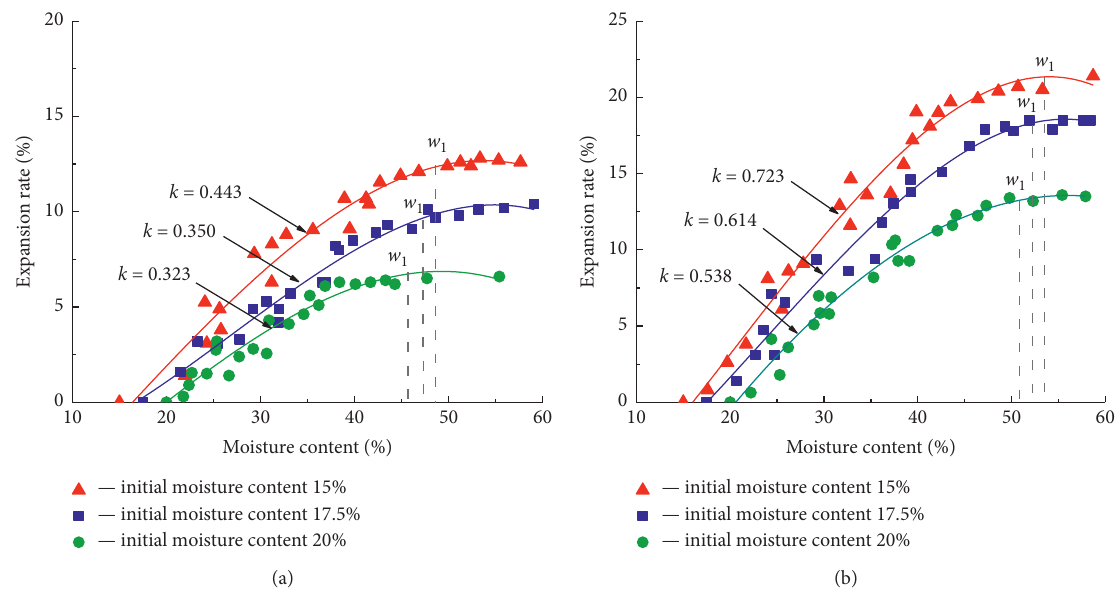
Figure 3: The relationship between the free load swelling rate and dry density. (a) Dry density 1.45g/cm 3 and (b) dry density 1.53 g/cm 3